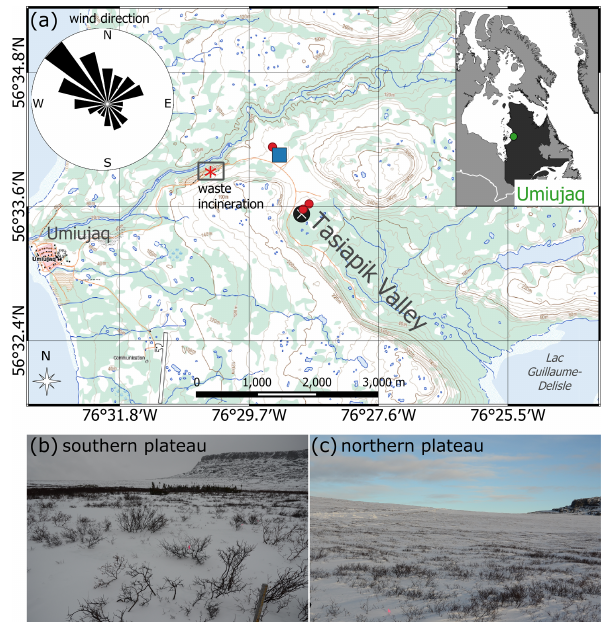
Figure 2. Map and photos of the study area in the Tasiapik Val- ley near the village Umiujaq. (a) In the map, the blue rectangle marks the area where irradiance profiles were measured in shrub- free snowpacks, the red dots mark where irradiance profiles were measured in snowpacks with shrubs, and a white cross marks the position of the automatic weather station (AWS). The site where waste was burned is denoted with a red star. The general wind di- rection for the time period from September to December is given by a wind rose and was calculated using data collected by the AWS from 2012–2019. (b) Landscape around sites in the south- ern plateau area and (c) landscape around measuring sites in the northern plateau area. Map source: Natural Resources Canada (http: //atlas.gc.ca/toporama/en/index.html, last access: September